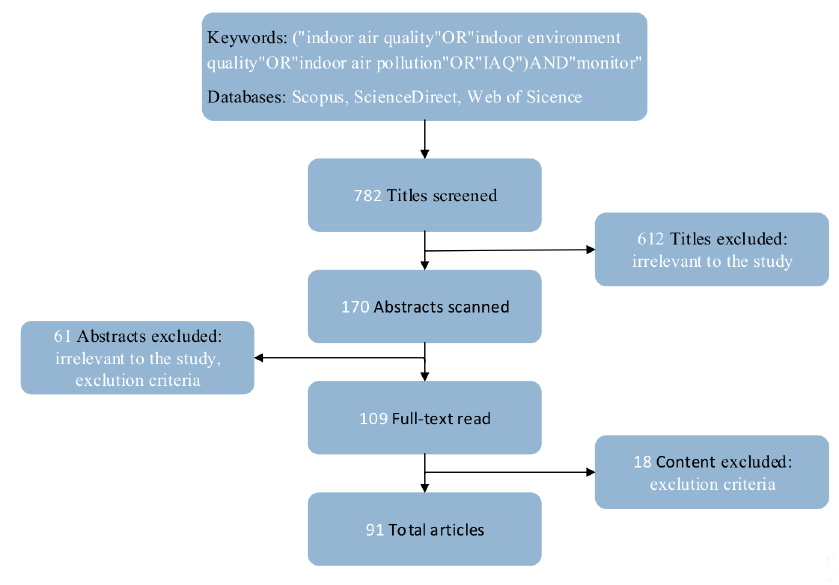
Figure 1. Systematic review